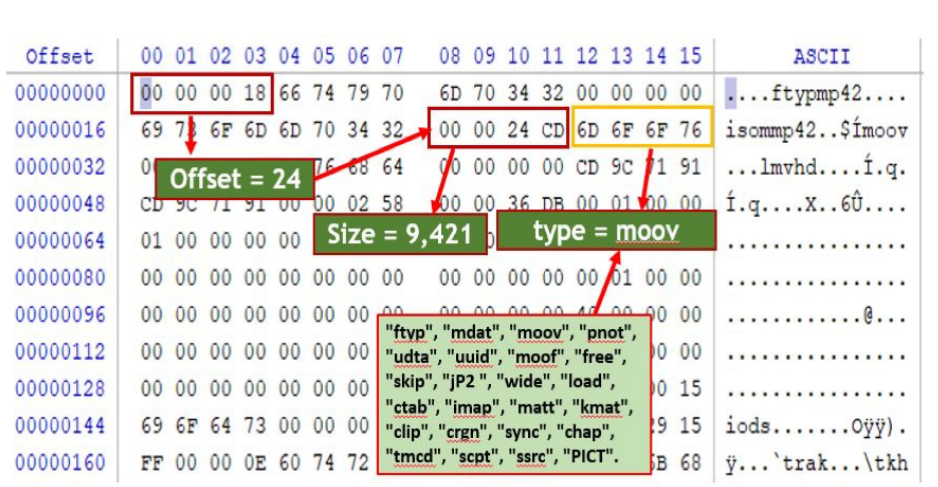
Figure 6. Second chunk of the sample MP4 file structure. The offset locations 16 through 19 and 20 through 23 are also considered a file signature sub-type, which could be defined by any of the signatures in the MP4 signature sub-type shown in Table